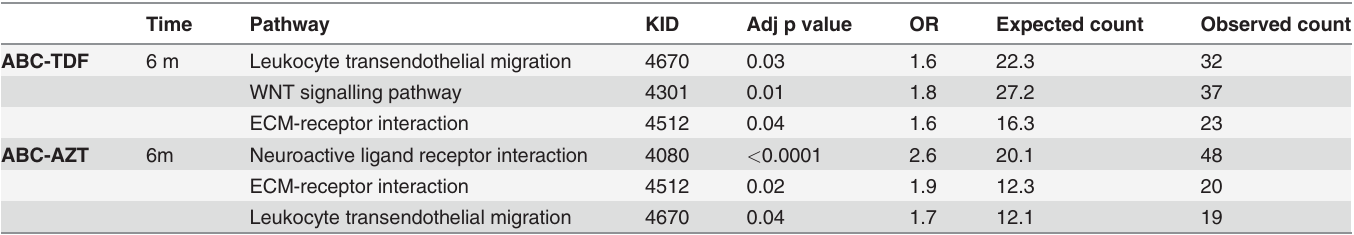
Table 4. Selected KEGG gene pathways overrepresented in a cross sectional comparison of ABC versus AZT and